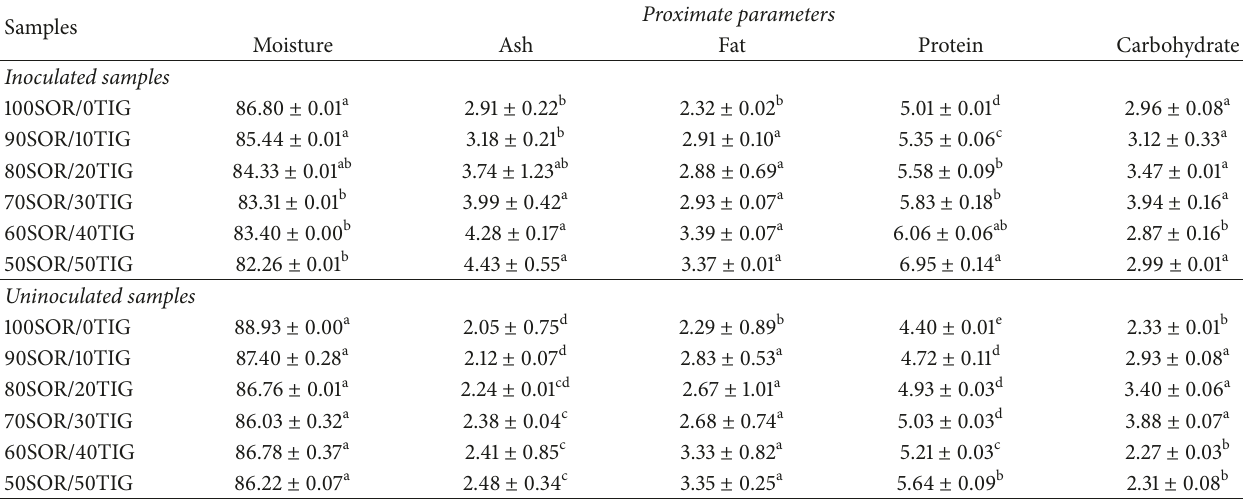
Table 1: Proximate composition of starter culture inoculated and uninoculated kunnu-aya .